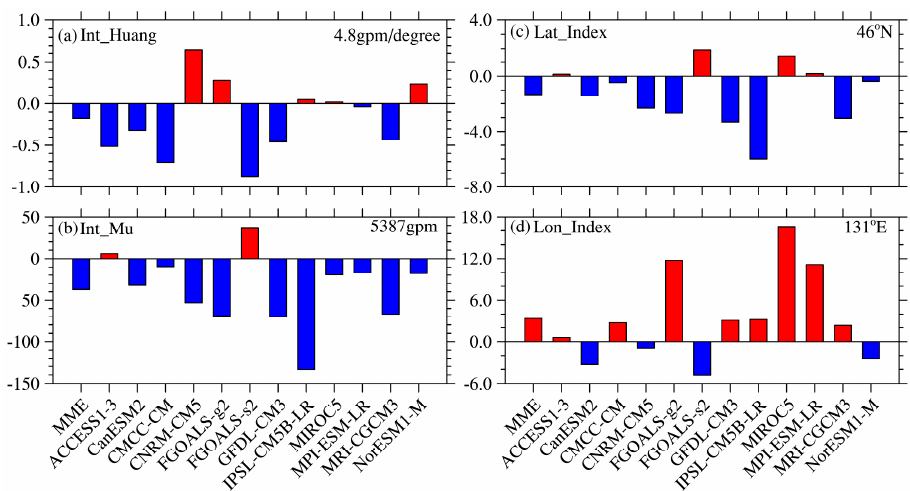
Figure 10. Differences in the long-term mean EAT-related parameters between the CMIP5 models and observations. ( a ) the dynamic intensity index, ( b ) the static intensity index, ( c ) the latitude index, and ( d ) the longitude index. The climatological mean in observations is presented at the top right in each panel.